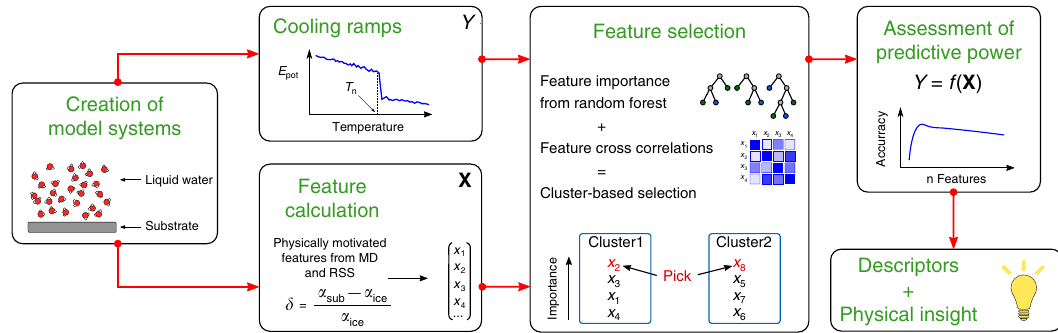
Fig. 2 Overview of the data-driven work fl ow employed in this study. In brief, we start by creating a diverse set of substrates covered by liquid water. By performing MD cooling ramps we establish their nucleation temperature T n , which is later used as dependent variable Y . Separately, we use these model systems to compute a large set of features, to be tested as independent variables X . We feed these data to a feature selection approach to select the most important parts of X . This is done by using the feature cross-correlations for distance-based clustering and then selecting from each cluster the most important feature, where the importance comes from a random forest model using all features. Subsequently, we check the predictive power over Y by machine-learning the dependence Y = f ( X ). Last, we employ state-of-the art feature interpretation techniques to gain physical understanding of the selected